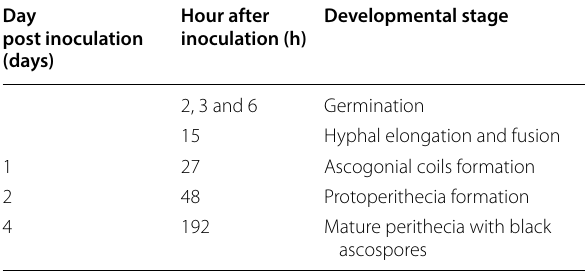
Table 3 Time courses used in this study